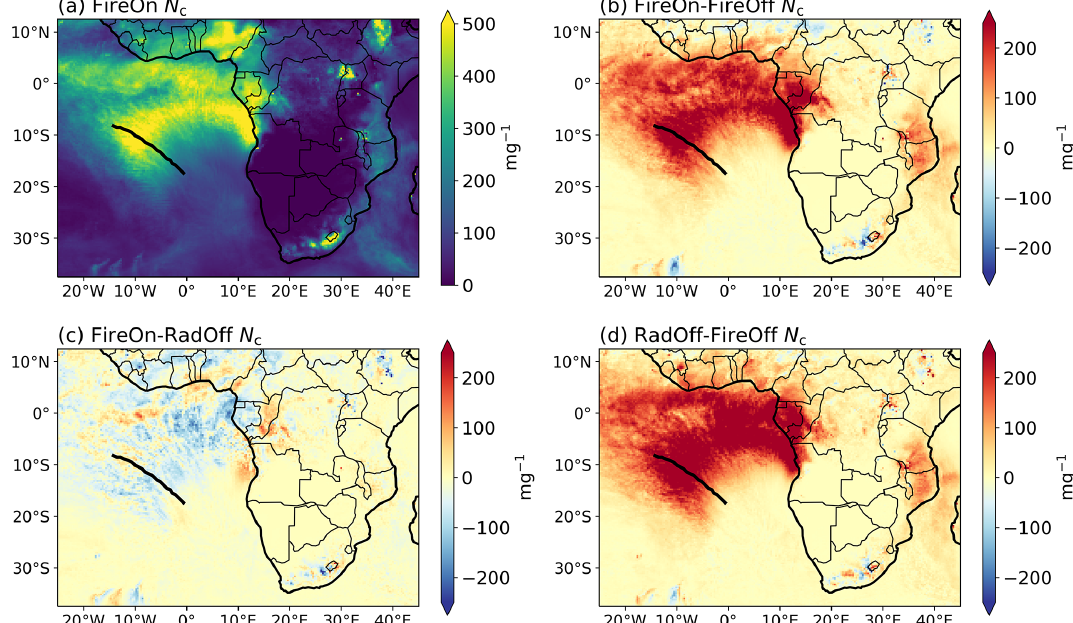
Figure 13. Cloud droplet number concentration differences for the full simulation period. Average cloud-weighted Nc is shown for (a) FireOn and the (b) FireOn–FireOff, (c) FireOn–RadOff, and (d) RadOff–FireOff differences. The black line represents the Lagrangian trajectory